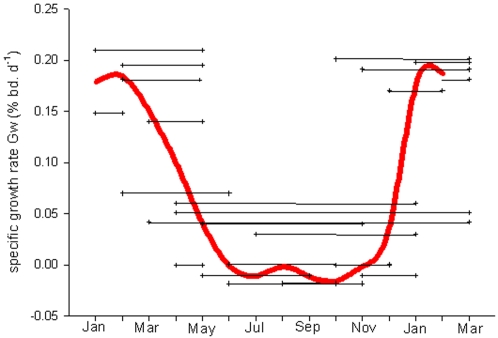
The mass specific growth rate (Gw) of free-ranging and sea-caged N. coriiceps.
A total of 21 immature adult N. coriiceps (4 recaptured twice) were tagged, released and then recaptured between 2nd Jan 2004 and 12th March 2005. The black crosses indicate the date of first and subsequent capture and the average Gw for an individual fish during its days at liberty indicated by the connecting black line. The red line connects calculations of Gw (n = 6) measured from sea-caged fish every 8 weeks. For clarity the standard error is not shown on the graph, which from May to Oct was <0.003% bd. wt. d−1, and from Nov to Apr <0.031% bd. wt. d−1).